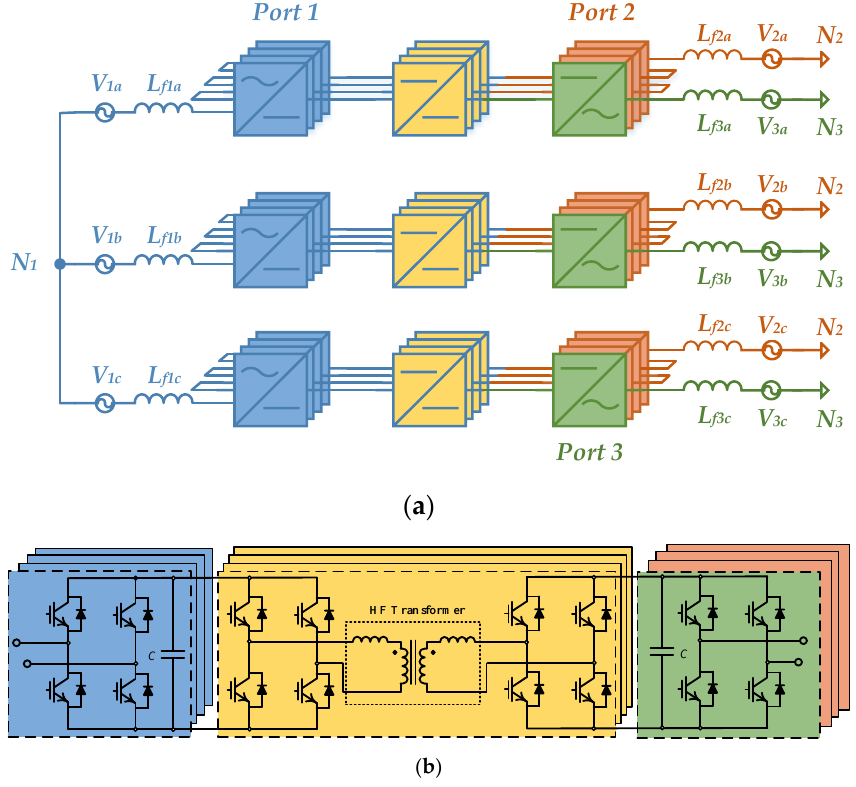
Figure 16. ( a ) UNIFLEX-PM modular per-phase architecture. ( b ) Conceptual schematic of a single AC/DC/AC module.